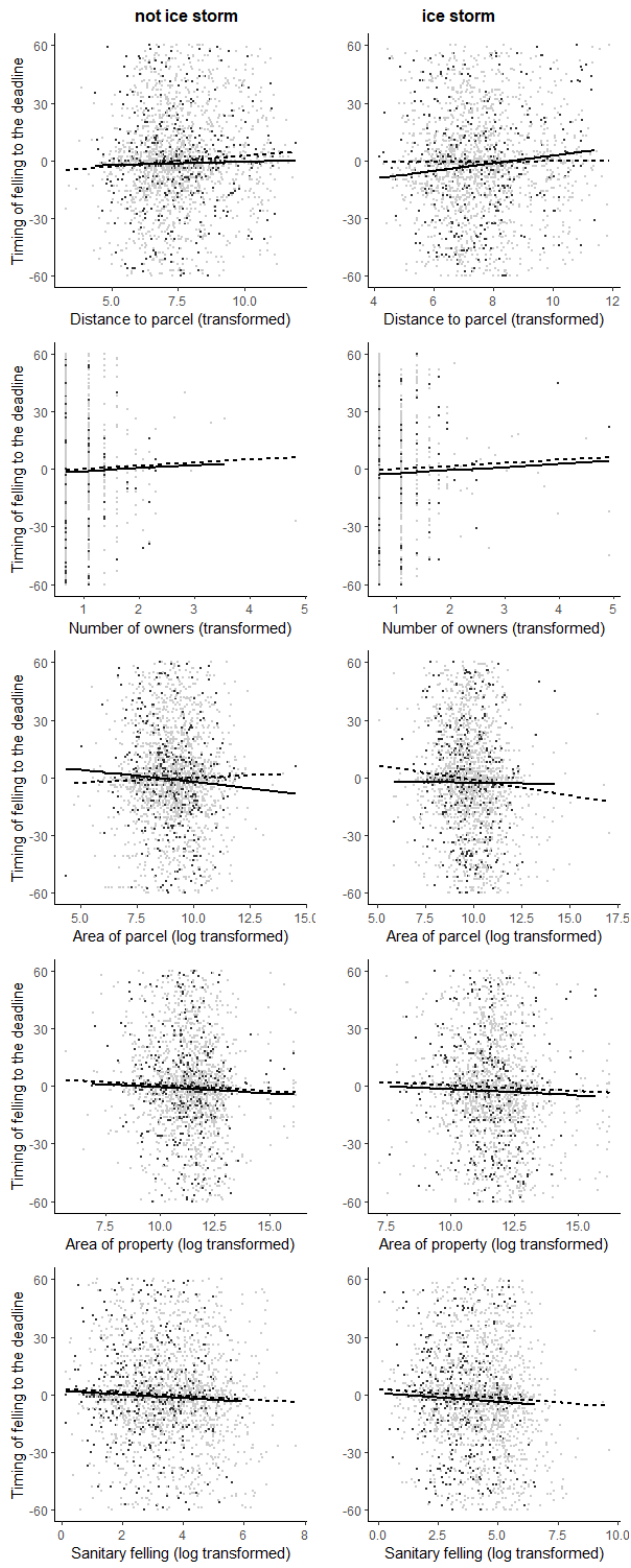
Figure 3. Associations of the different characteristics of the privately owned parcels with the presence of the ice storm and the amount of spruce with the timing of felling in the winter period. The grey dots and the black dashed line show a high amount of spruce, and the black solid line and black dots show a low amount of spruce.